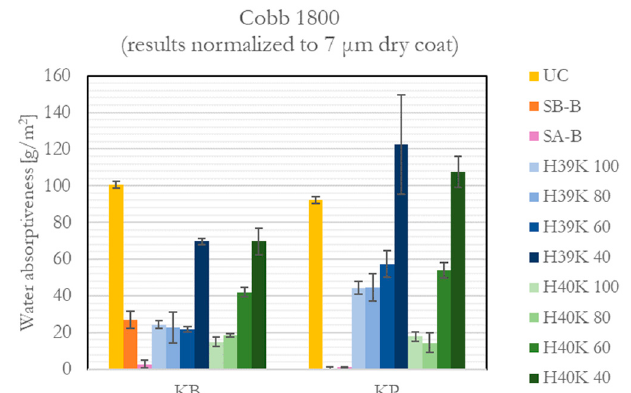
Figure 3. Water absorptiveness (Cobb 1800) values for the uncoated (UC), commercial (SA-B and SB-B), and experimental dispersion coatings. SB-B), and experimental dispersion